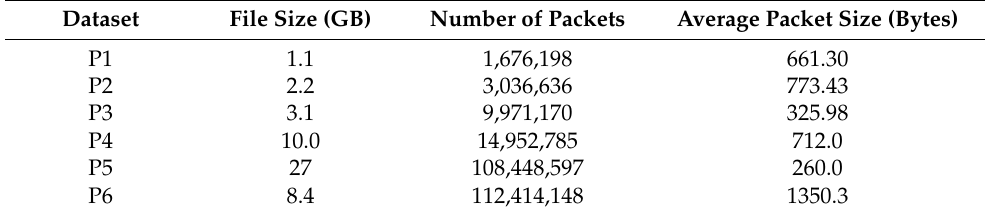
Table 2. Description of six sample packet trace